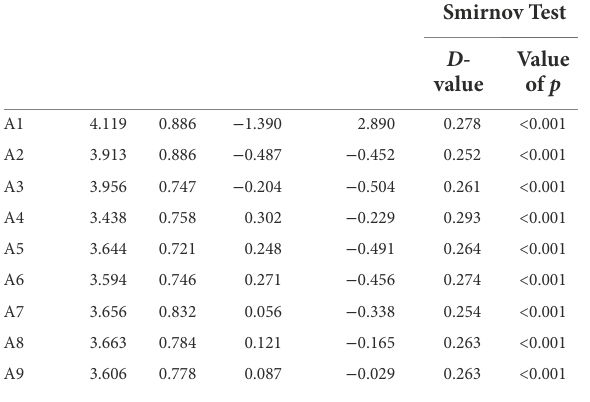
TABLE 3 Normality test results for PETJSS items. Code Mean